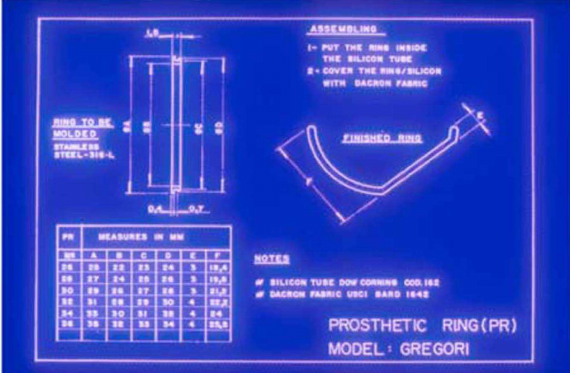
Fig. 11 – Technical drawing. The assembly of the prosthetic semicircular ring. Left: measurements of the largest diameter (in millimeters) in A. Right: attention to the rectification on the right that will correct the posterior dilation of the mitral annulus which is greater next to the posteromedial commissure